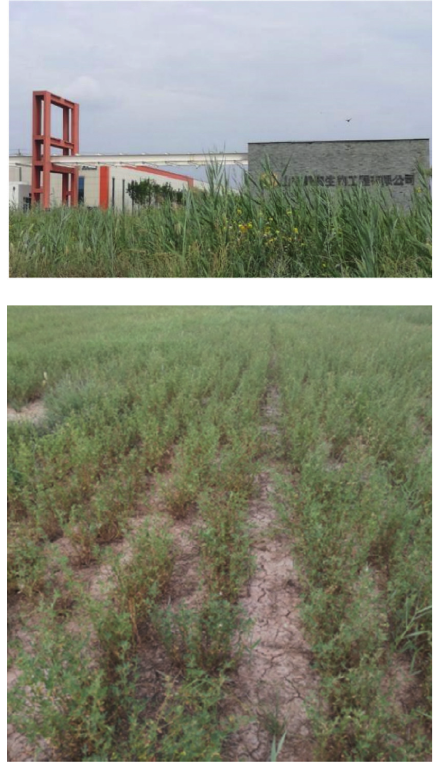
Figure 1: The local saline-alkali